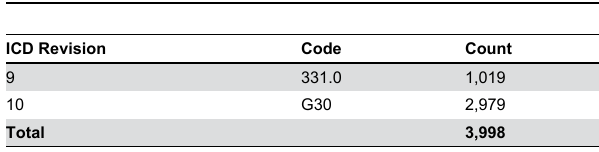
Table 1. Number of Alzheimer’s deaths identified in the UPDB by ICD